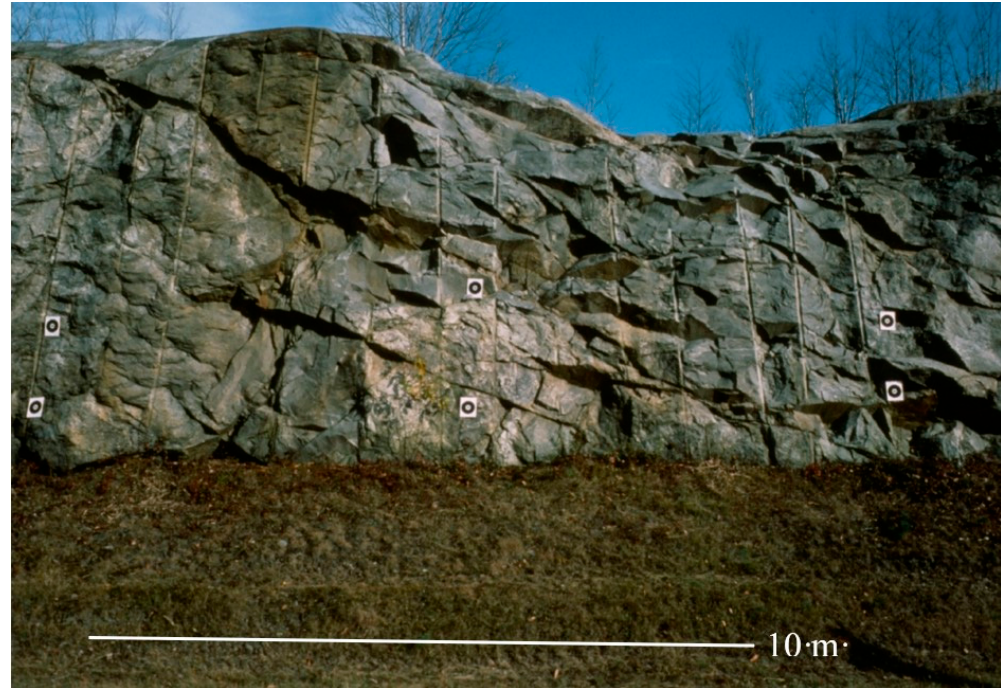
Figure 2. Photograph of a N5E striking roadcut exposure at the study site on I-93 containing NE striking, SE dipping faults included in this study. Note, most of the faults fractures exhibit dark planar surfaces. The rock type is primarily Concord granite (dark gray) with a Lower Rangeley schist block (light grey/white) exposed to the right of center above where the grass meets the bedrock and between the first and fourth drillhole from the left side of the photo. The subvertical lines are drill holes used in blasting the roadcut surface. Targets were used for rectification of photographs on which the geology and fractures were mapped by [16] (sheet 2).